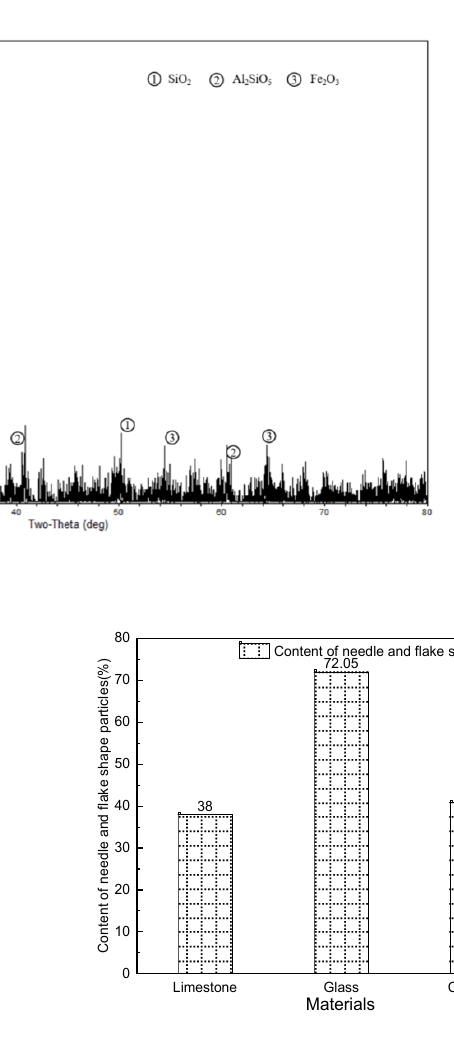
Figure 2. XRD results of glass.